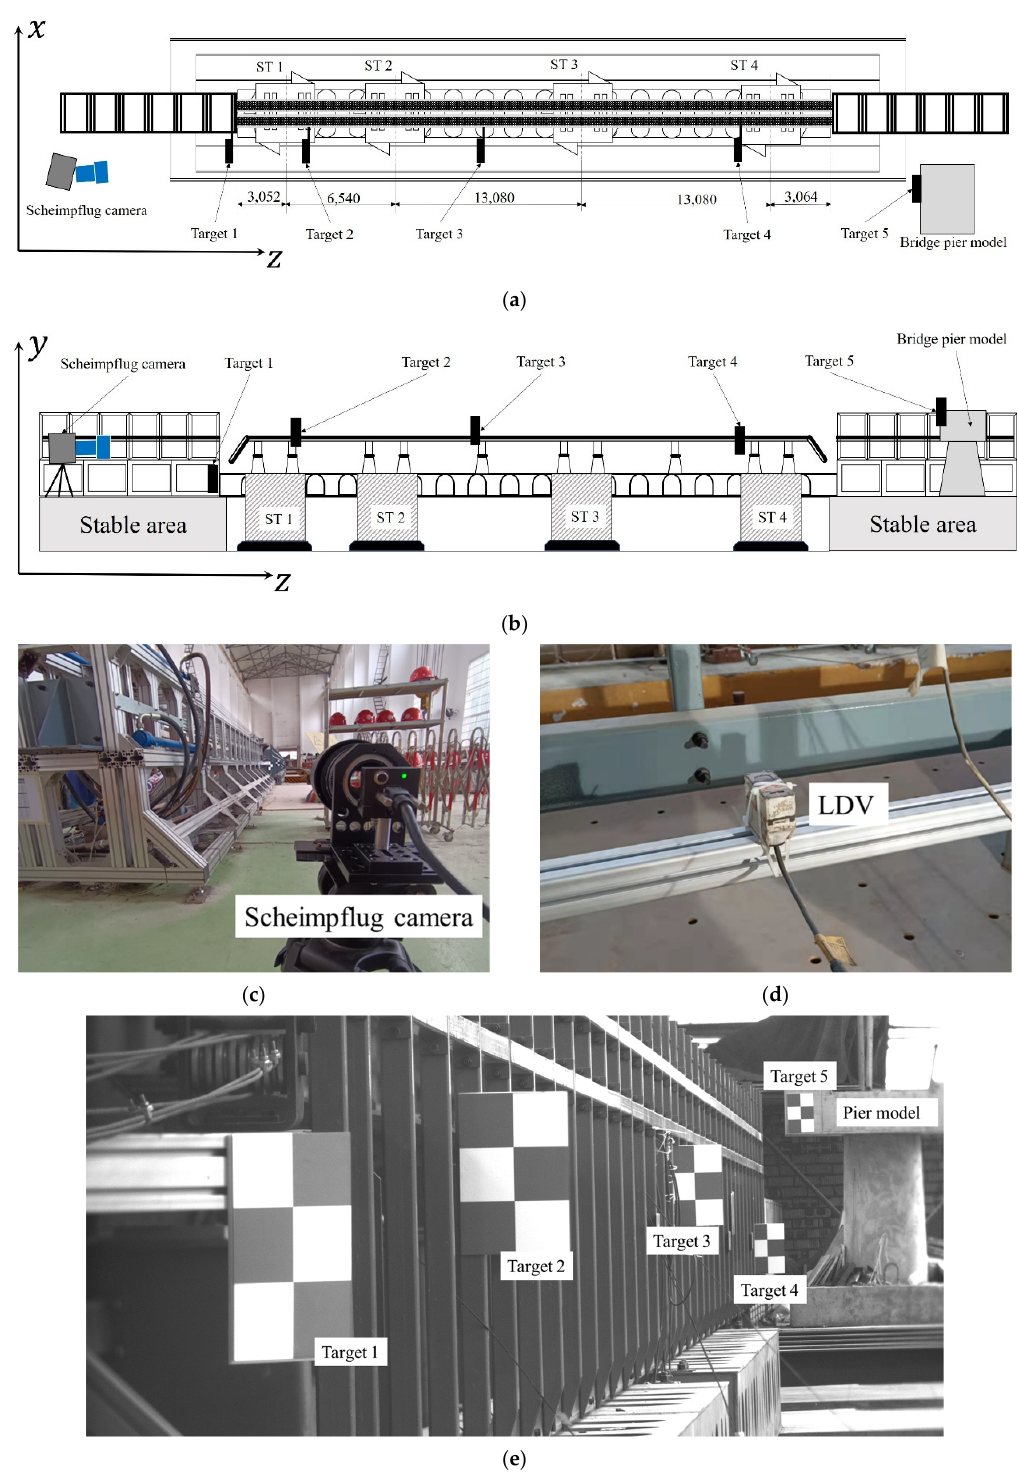
Figure 15. Experiment setup of the bridge model experiment. ( a ) Geometric configuration in the bridge model experiment ( top-view ). ( b ) Geometric configuration in the bridge model experiment ( side-view ). ( c ) The Scheimpflug camera. ( d ) The LDV installed at the bottom of the model. ( e ) An example of images captured by the Scheimpflug